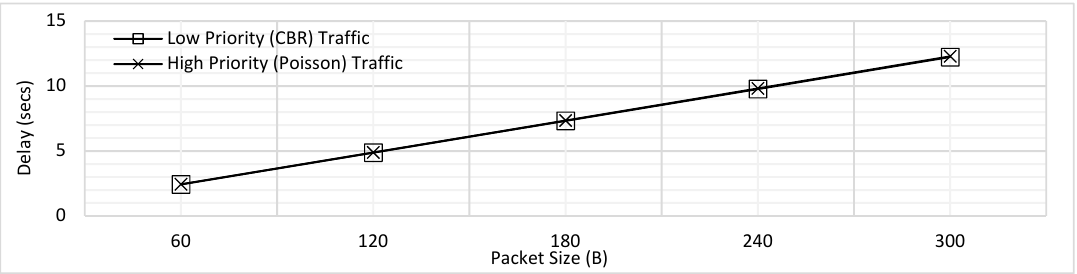
Figure 3. Maximum Delay of Low and High Priority Traffic for the FCFS Scheme.